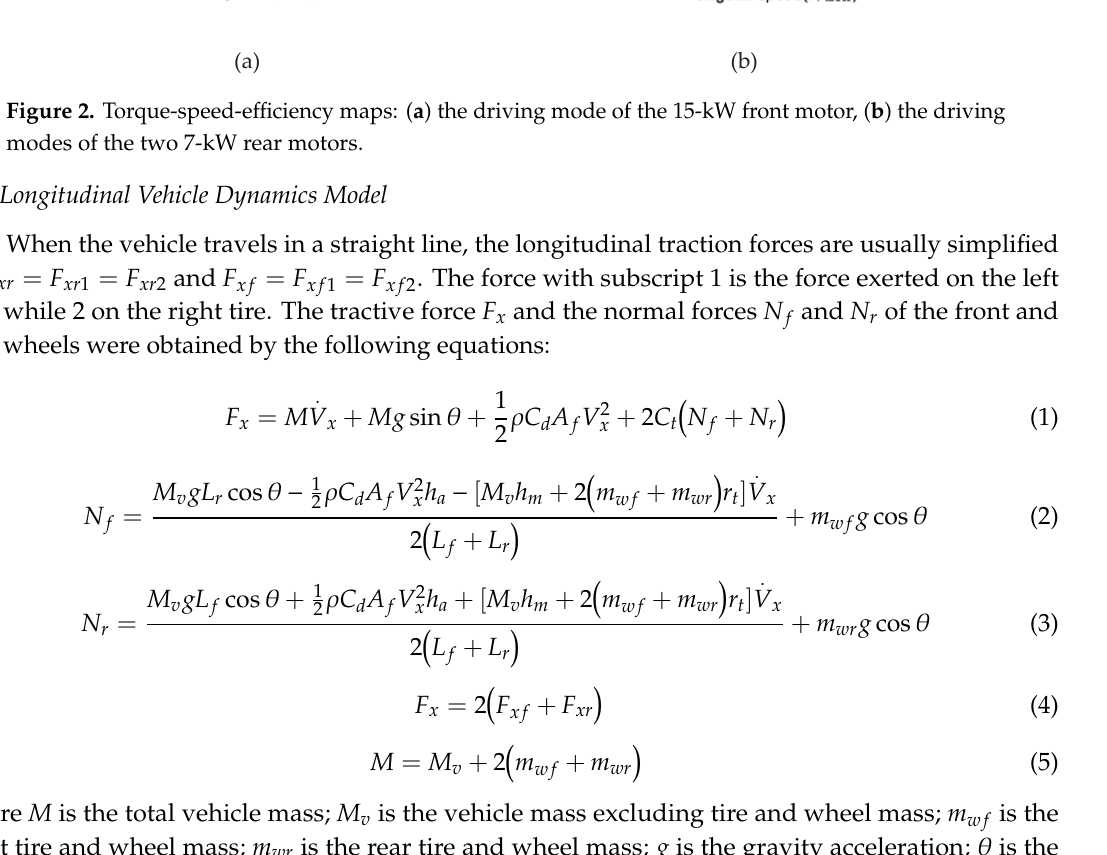
Table 1. Vehicle Specifications.